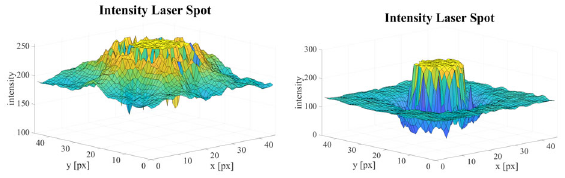
Figure 13. Intensities of a laser spot of the Mamiya ZD; left: red colour channel, right: green colour channel